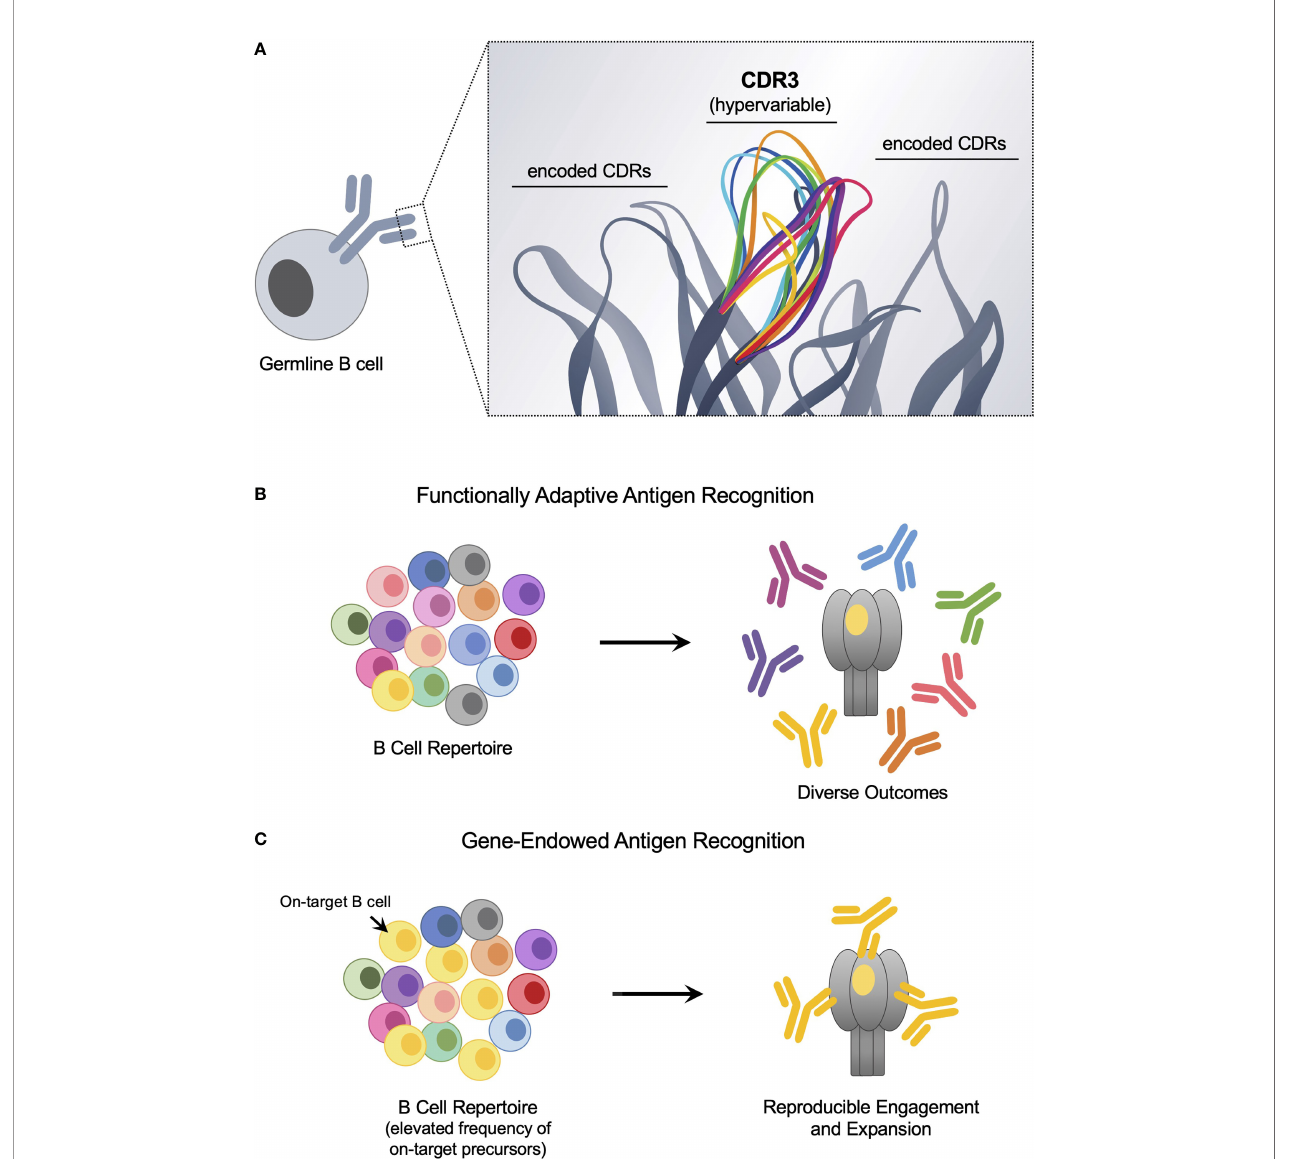
FIGURE 1 | The antigen-binding surface of the germline BCR harbors functionally adaptive and ‘ innate-like ’ antigen targeting solutions. (A) The antigen-binding site of the germline BCR is formed by antibody V gene-encoded CDRs and hypervariable CDR3s that are centrally positioned. BCR diversity is a product of combinatorial assortment of the gene-encoded CDR repertoire and stochastic N-junctional diversi fi cation, which generates deep plurality in the CDR3. (B) As diversity is concentrated within the hypervariable CDR3, these loops are the principal source of binding energy to engage new antigen, providing functionally adaptive antigen receptor activity. However, If CDR3-centered targeting solutions are rare, then the corresponding on-target BCRs will be poorly expanded following immune challenge. (C) Gene-endowed antigen recognition can occur when speci fi c encoded CDRs supply reproducible and deterministic speci fi city to a target epitope. This reproducibility can be exploited to ‘ pathway-amplify ’ otherwise immunologically subdominant vaccine